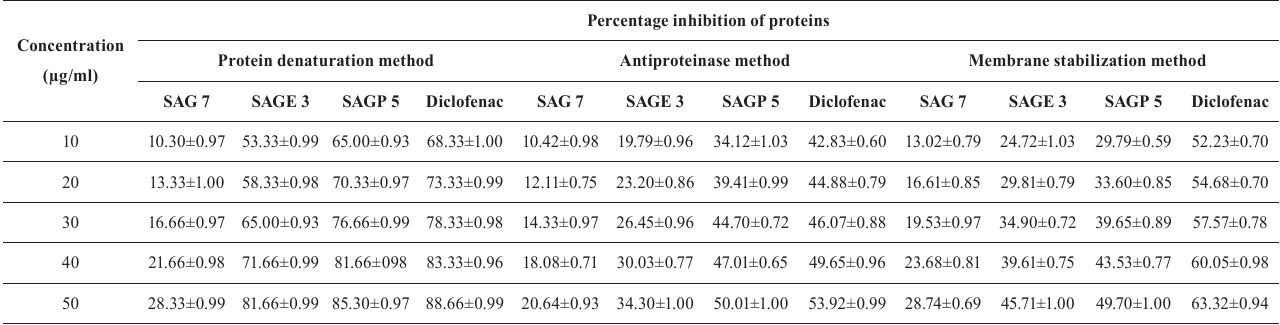
TABLE V - R esults of in vitro anti arthritic activity of optimized formulations, SAG, SAGE and SAGP